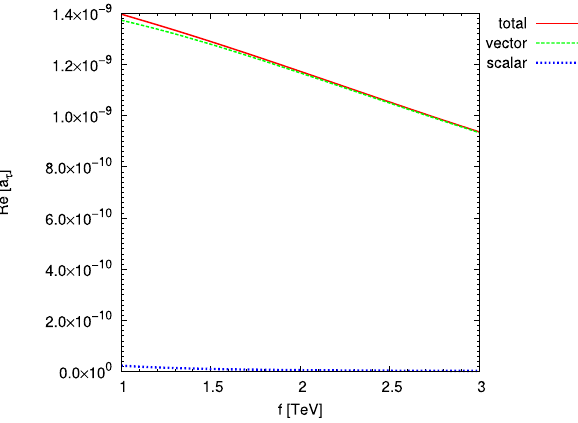
Fig. 4 Scalar–vector (s–v), scalar, vector, and total contributions to a W τ . a Re( a W τ ). b Im( a W τ ). The plots are obtained with the fixed value of F = 4000 GeV. The values provided in Table 3 are used for the remaining model